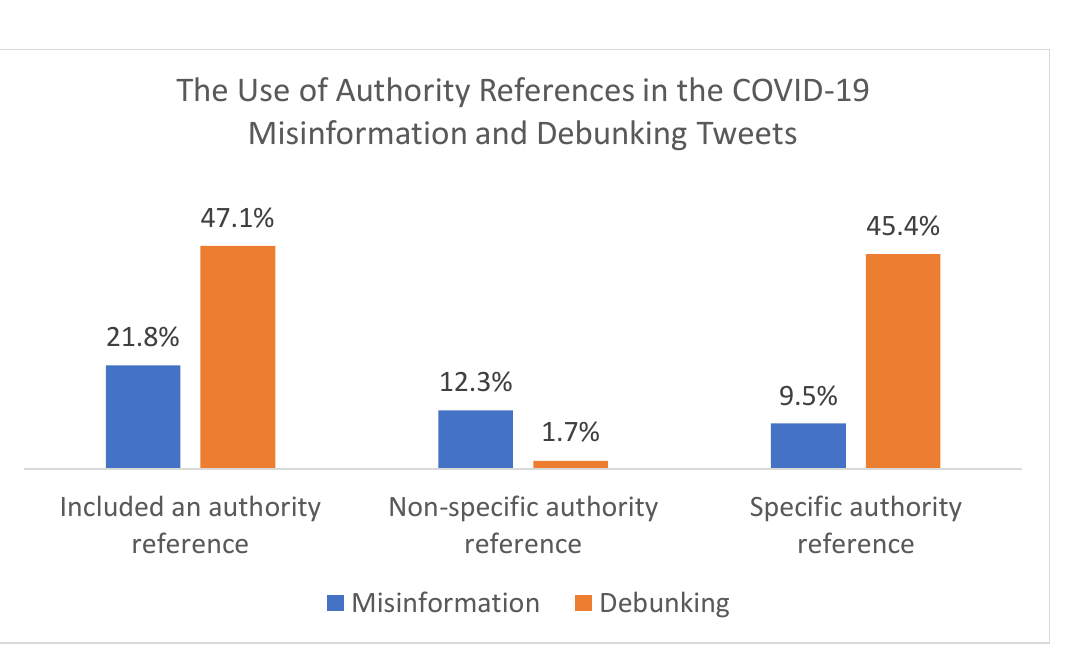
Figure 1. The use of authority references in the COVID-19 misinformation and debunking tweets. Debunking tweets were more likely than misinformation tweets to include an authority reference. Misinformation tweets were more likely than debunking tweets to include appeals to non-specific authority references. Debunking tweets were more likely than misinformation tweets to include appeals to specific authority references. Differences significant at p < .001